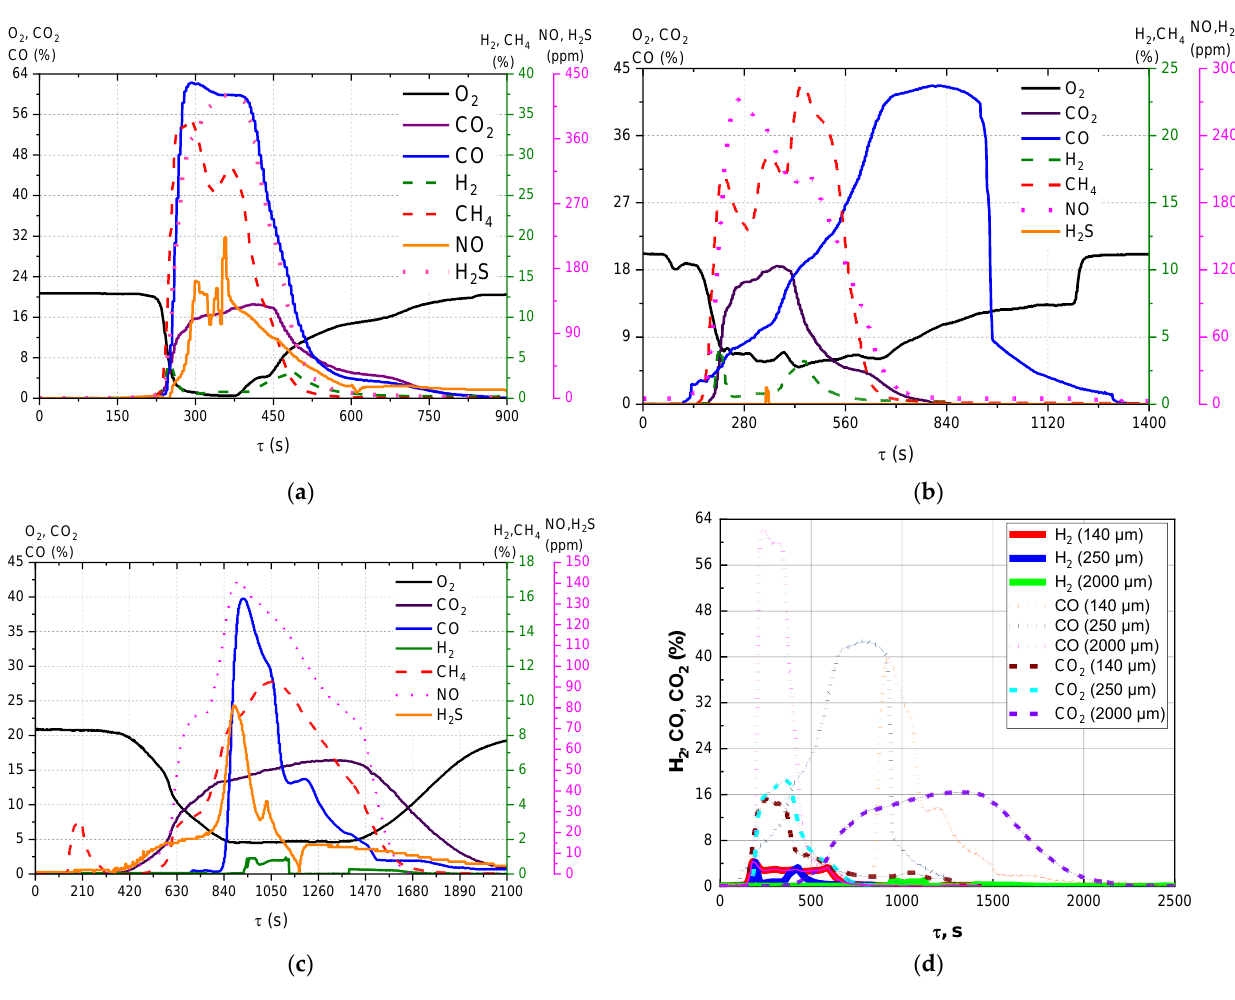
Figure 16. Trends of the concentrations of gas mixture components when varying the biomass particle size: 140 μm ( a ) ; 250 μm ( b ) ; 2000 μm ( c ); a comparison of component concentrations ( d ). It has been established (Figure 16) that the H 2 release starts from the first seconds of heating during the pyrolysis of particles with a size of 2000 μm. In this case, the longest time for the release of pyrolysis gas was observed. The shortest gas emission time was recorded during the pyrolysis of particles with an average size of 140 μm. During the pyrolysis of particles of this size, one peak in the concentrations of CO and CO 2 (62.5% and 19%, respectively), as well as two peaks in the concentrations of CH 4 , were observed (Figure 16a). Figure 17 shows the average and maximum concentrations of the gas mixture components. Experiments have shown that pyrolysis of smaller particles (140 µ m and 250 µ m) gives higher concentrations of CH 4 and H 2 (Figure 17). The yield of CO during the pyrolysis of sawdust with a particle size of 140 µ m increased by 12% and 65% compared to particles with a size of 250 µ m and 2000 µ m, respectively (Figure 17a). A similar comparison was made for other gases: the CO 2 yield increased by 1.5% and 15%, the CH 4 yield increased by 30% and 60%, and the H 2 yield increased by 1.5% and 43%. During the pyrolysis of biomass with a particle size of 140 µ m, the maximum yield of CH 4 and H 2 increased by 3 and 1.5 times, respectively, compared with the particles of 2000 µ m (Figure 17b). Table 7 shows the gas flow rates obtained during the